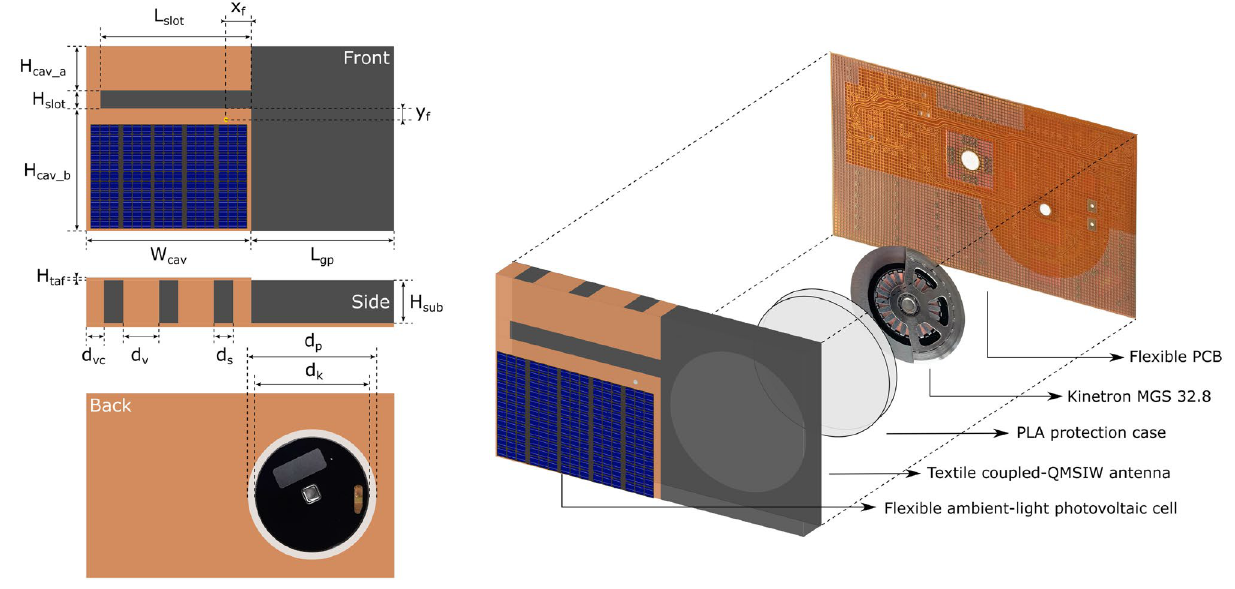
Figure 1. Proposed coupled-QM SIW antenna topology with flexible ambient-light photovoltaic cell integrated on top and Kinetron MGS 32.8 integrated inside the substrate, top view, side view and bottom view on the left hand side, and in 3D on the right hand side (H cav_a = 12 mm, H cav_b = 34 mm, H slot = 5 mm, H taf = 0.08 mm, H